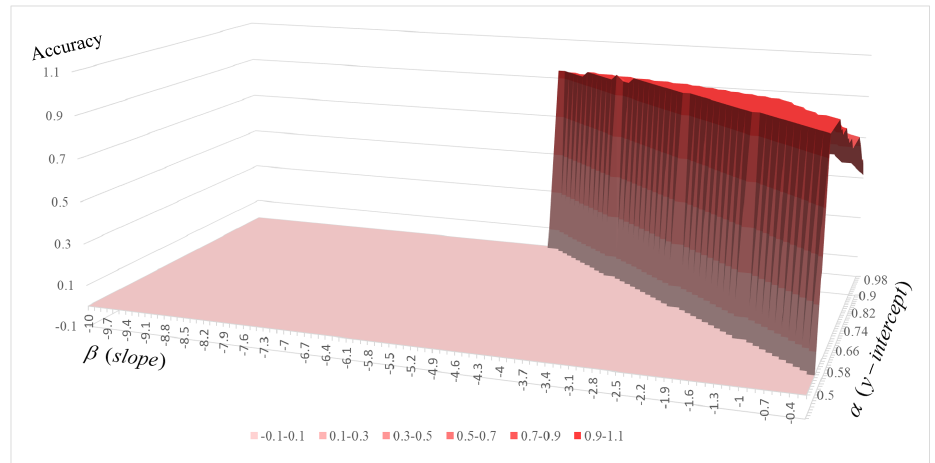
Figure 4. Accuracy distribution for distinguishing successfully tracked frames and failed frames according to α and β